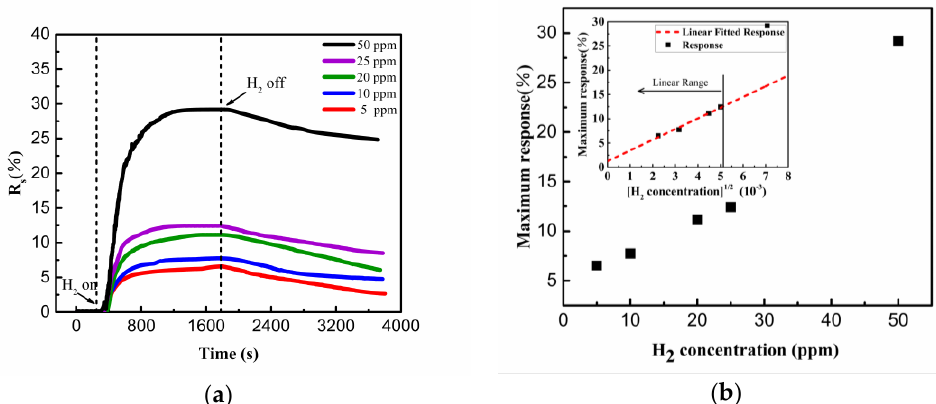
Figure 8. ( a ) The response of the sensor under different H 2 concentrations at 70 °C. ( b ) The maximum response as a function of square root of H 2 concentration.